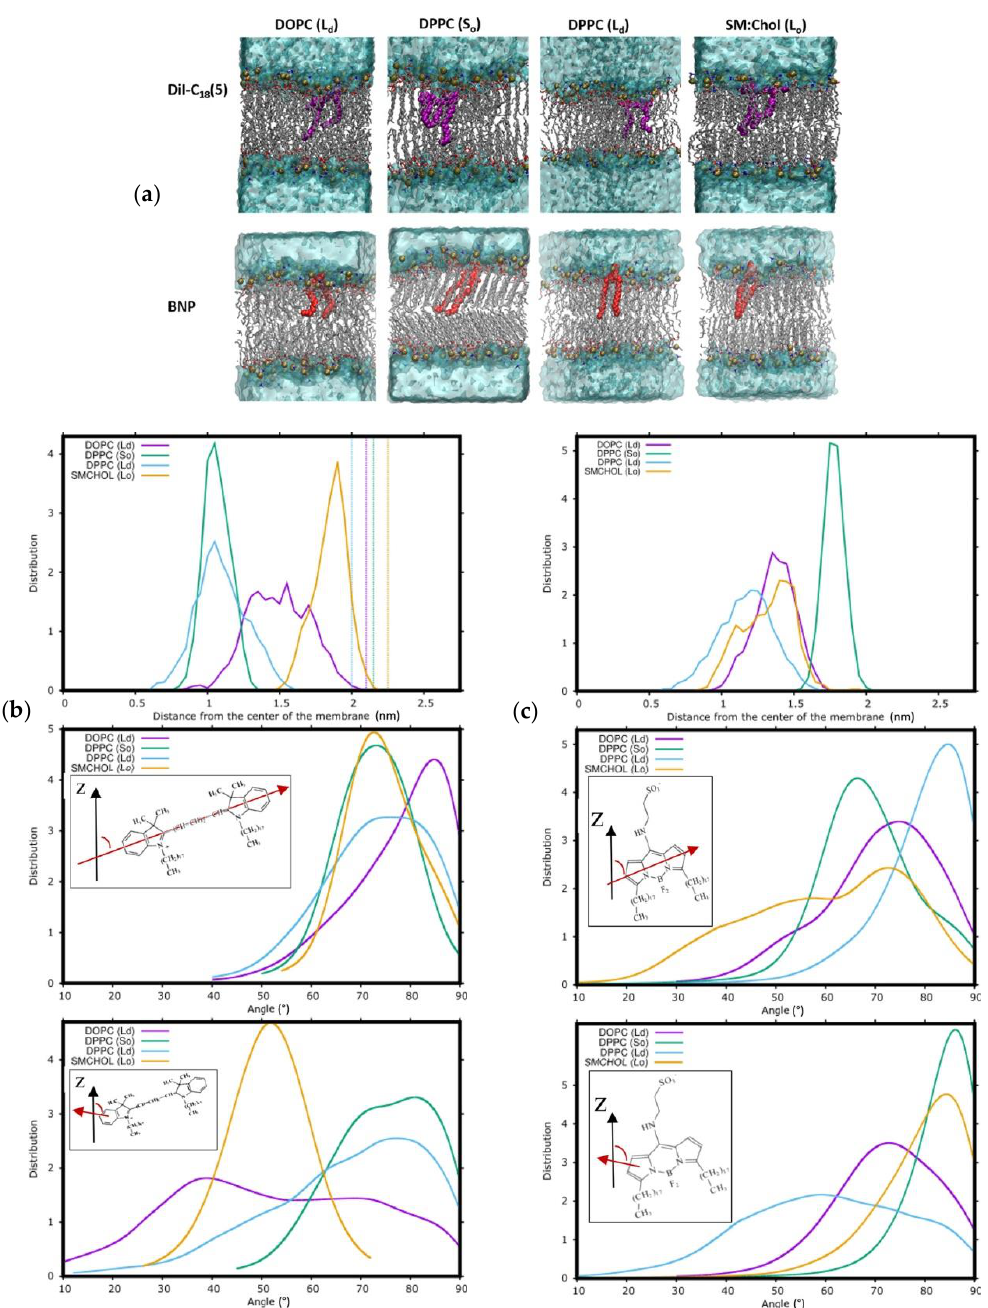
Figure 9. ( a ) Illustrations of the DiI-C18(5) (DiD) and BNP probes in different environments under investigation in the current study. ( b ) DiD in various membrane phases: (top) the position of the middle atom of the cyanine backbone of DiD along the z -axis expressed in terms of the distance from the center of the membrane, the dotted vertical lines denote the most abundant position of the phosphorus atoms; (center) the angle between the transition dipole moment and the z -axis; and (bottom) the angle between the axis perpendicular to the plane of the DiD molecule and the z -axis. ( c ) BNP in various membrane phases: (top) the position of the boron atom along the z -axis expressed in terms of the distance from the center of the membrane; (center) the angle between the transition dipole moment and the z -axis; and (bottom) the angle between the axis perpendicular to the plane and the z -axis. Reprinted with permission from [129]. Copyright 2018 American Chemical